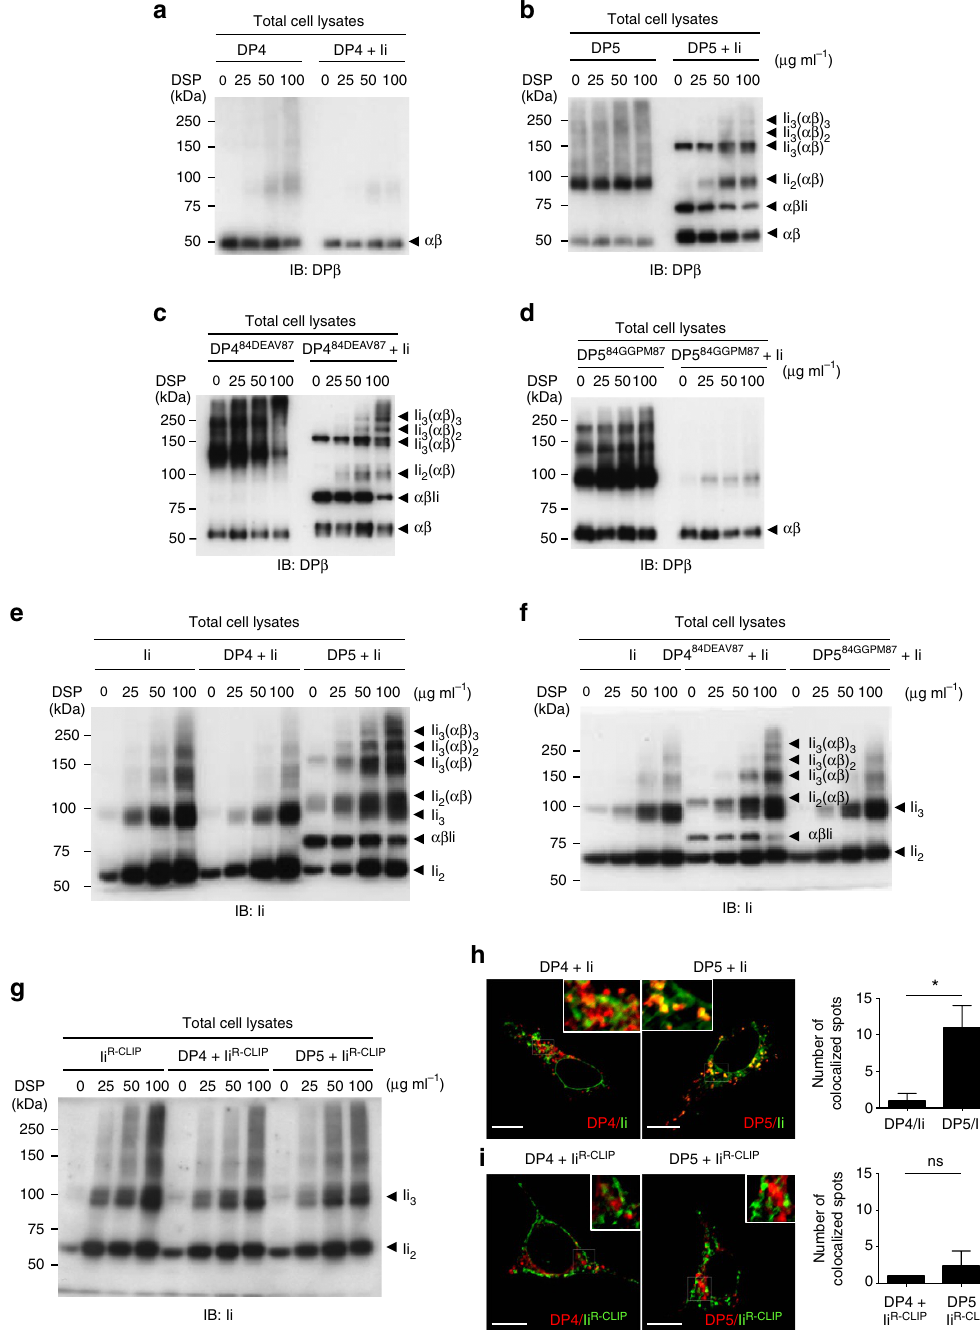
Figure 3 | DP 84DEAV87 but not DP 84GGPM87 molecules form a nonamer complex with Ii via the CLIP region. ( a – g ) HEK293 cells were transiently transfected with the indicated combinations of genes. Cells were treated with DSP, a chemical crosslinker, at the indicated concentrations for 2h. Non-reduced samples were immunoblotted with anti-DP b ( a – d ) or Ii ( e – g ) mAb. ( h , i ) HEK293 cells were transfected with the indicated combinations of genes. Fixed cells were permeabilized and stained for Ii ( h ) or Ii R-CLIP ( i ; green) and DP (red), and then analysed by confocal microscopy. Inset boxes indicate the areas shown at higher magnification. Note that HEK293 cells are deficient in class II and Ii expression. Scale bar in all images, 10 m m. Quantification of co-localized spots represents means ± s.d. of three counted cells in each condition. ns, not significant; * P o 0.05 by unpaired, two-tailed Welch’s t -test. endogenous model antigen, whose MAGE-A3 243–258 peptide is and are thereby capable of endogenously processing naturally processed and presented by DP4 (ref. 31). Mutant and presenting class I-restricted peptides when transduced MAGE-A3 protein targeted to the endosomal/lysosomal pathway with a class I gene 32 . To examine whether inhibition of was used as a control exogenous model antigen. Class I- and proteasome function prevents the production of peptides II-defective K562 cells, used as a backbone of artificial APCs derived from ubiquitinated cytoplasmic proteins, K562 aAPCs (aAPCs), are equipped with the normal proteasome machinery, were transfected with the native form or endosome-targeted form NATURE COMMUNICATIONS|8:15244|DOI: